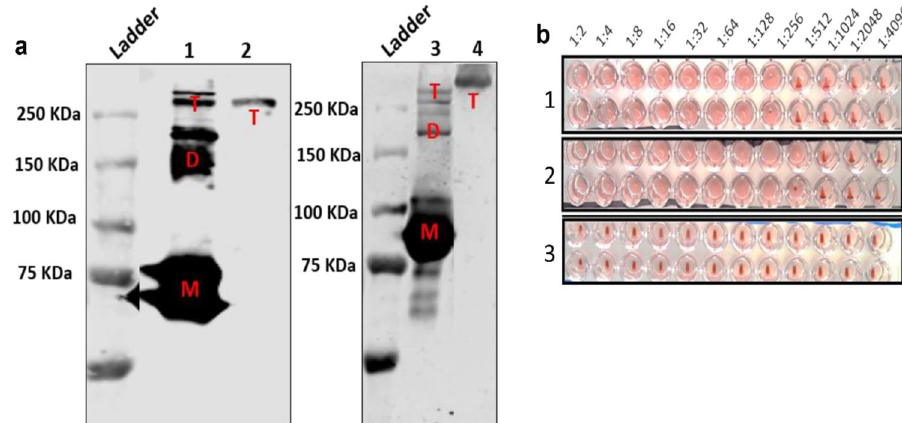
Fig. 2 Analysis of the oligomeric form and activity of recombinant H9HA ectodomain containing foldon. a BS3 cross-linking experiment for determining the native structure of H9HA ectodomain with foldon. Lane 1: rH9HA without BS3 Lane 2: rH9HA with 10 mM BS3 Lane 3: rH9HA-CD83 scFv without BS3 Lane 4: rH9HA-CD83 scFv with 10 mM BS3. About 15 µg of the recombinant protein was mixed with BS3 to a 10 mM fi nal concentration and incubated for 1 h at room temperature. The cross-linking reaction was stopped by the addition of 1 M Tris-HCl pH 8.0 to a fi nal concentration of 50 mM and incubated for 15 min at room temperature. After cross-linking, proteins were separated on 8% SDS-PAGE under reducing conditions, blotted, and analysed by western blot using anti-H9HA monoclonal antibody. M: monomer (70 kDa* 100 kDa^) D: dimer (140 kDa* 200 kDa^) T: Trimer (210 kDa* 300 kDa^) *rH9HA ^rH9HA-CD83 scFv. All blots were derived from the same experiment and were processed in parallel. b Haemagglutination assay to test the activity of recombinant H9HA with foldon to agglutinate